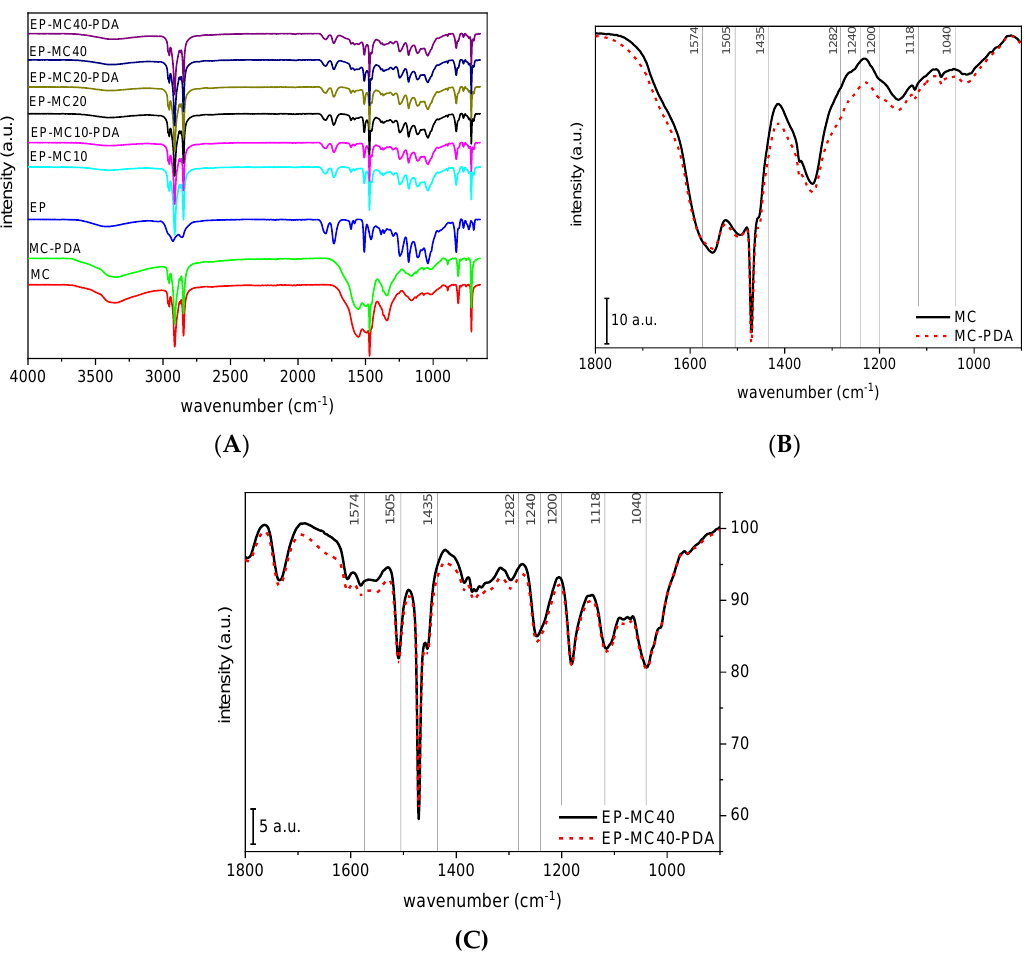
Figure 3. Results of attenuated total reflectance–Fourier-transform infrared spectroscopy (ATR–FTIR). ( A ) Overview of the spectra of all the investigated samples. ( B ) Detail of Fourier-transform infrared spectroscopy (FTIR) spectra of neat and PDA-coated microcapsules. ( C ) Detail of FTIR spectra of composites EP-MC40 and EP-MC40-PDA. Vertical lines indicate typical IR absorption bands of PDA. Intensity is reported in percentage points.